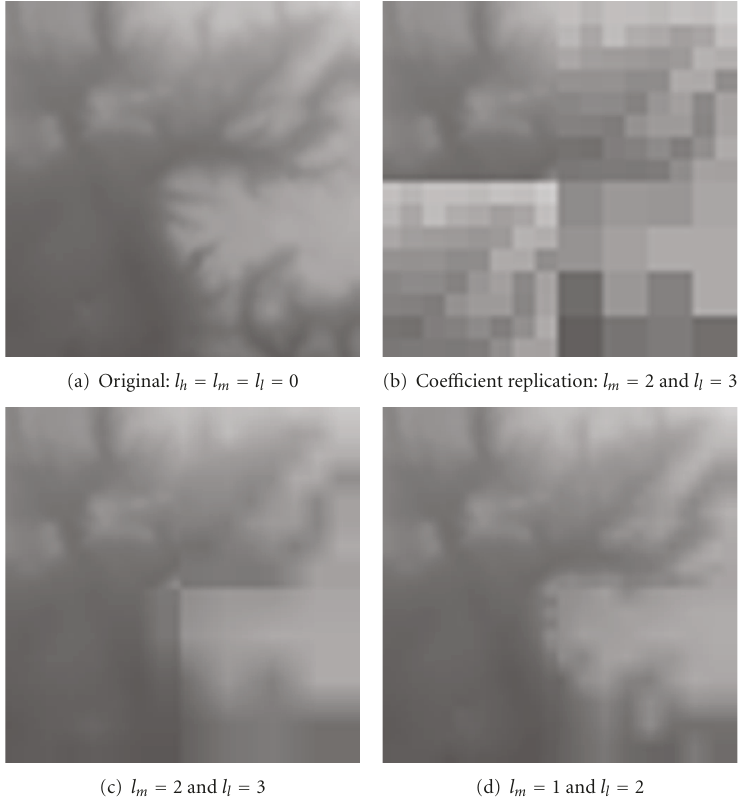
Figure 15: Example DEM tessellation without smoothing ( l h = 0).